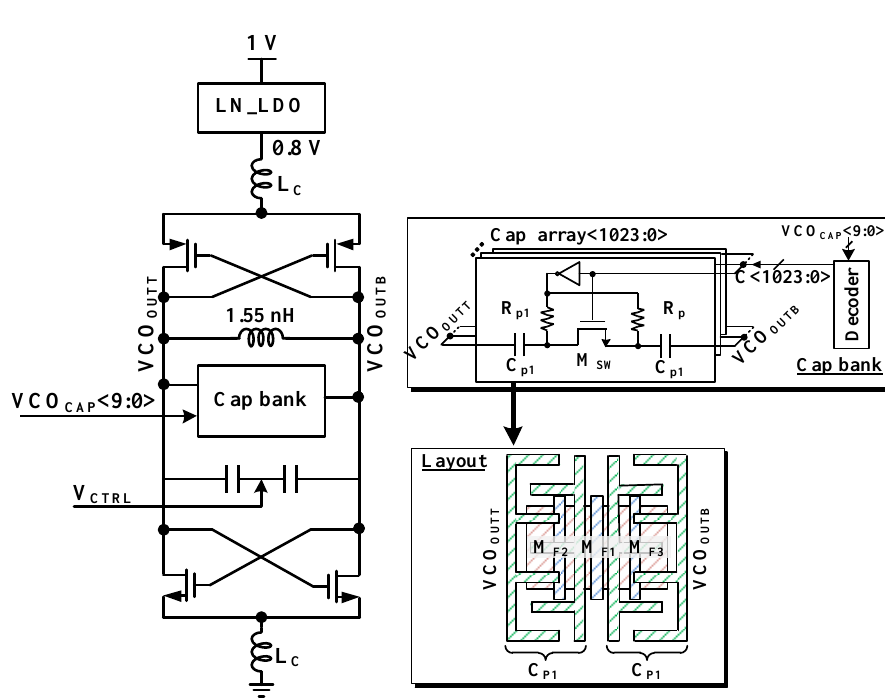
Figure 4. ( a ) Block diagram and ( b ) timing diagram of the ABC block.